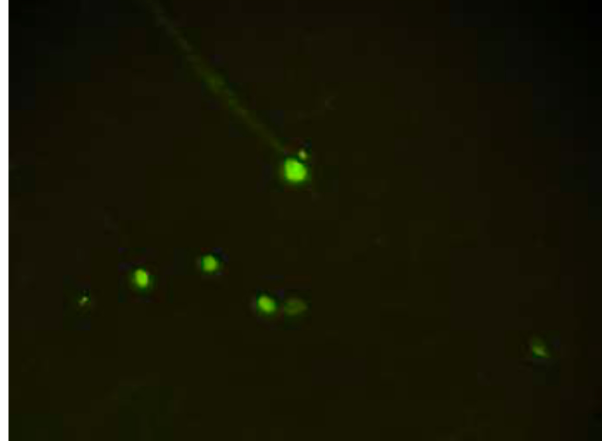
Figure 1. CD34 expression was characterized by the presence of green luminescence in endothelial progenitor cell